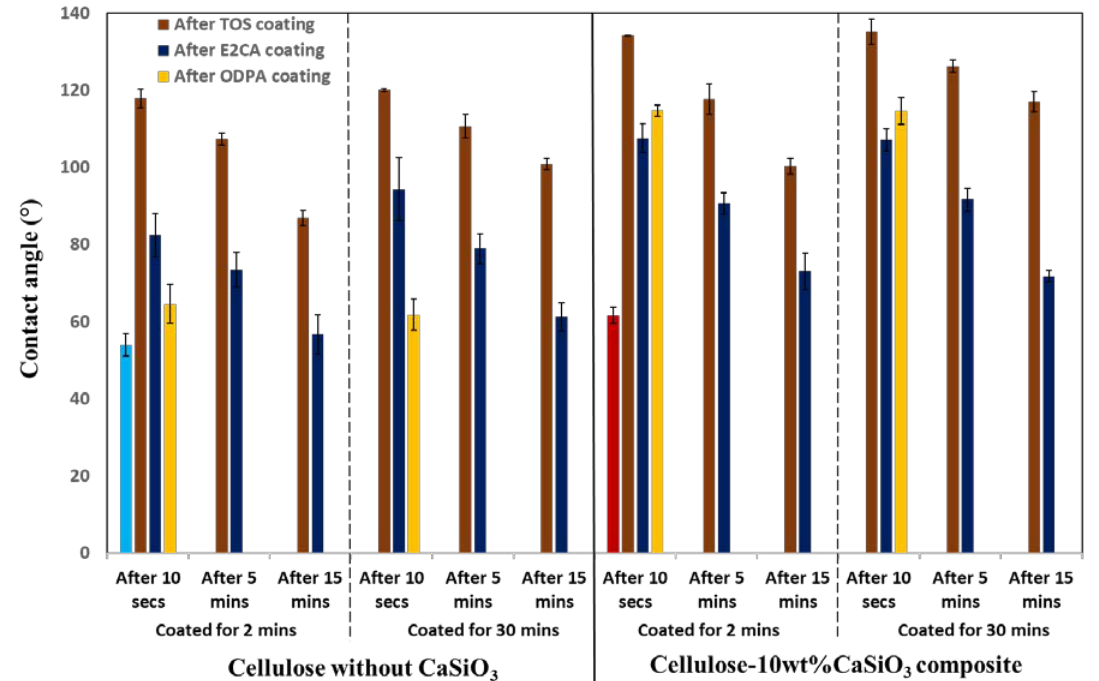
Figure 2. Surface contact angle measurements on cellulose–CaSiO 3 composites coated with hydrophobising agents TOS, E2CA and ODPA without CaSiO 3 before coating, with 10 wt% CaSiO 3 .